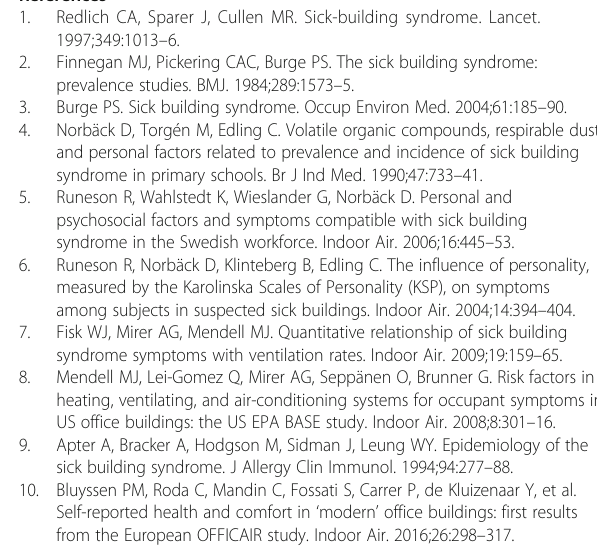
Additional file 1: Table S1. Univariate analysis for the association with weekly building-related symptoms. Table S2 Number of cases by variable factors for weekly building-related symptoms. (DOCX 59